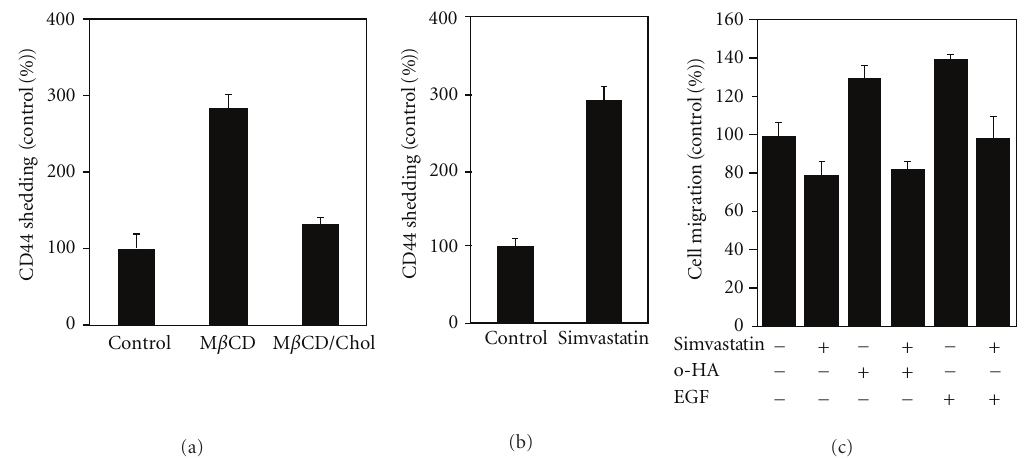
Figure 1: Cholesterol lowering stimulates CD44 shedding and suppresses cancer cell migration. (a) Modulation of cellular cholesterol a ff ects CD44 shedding from human glioma cells. Cells were cholesterol-depleted (M β CD), cholesterol-replenished (M β CD/Chol), or left untreated (control), and CD44 shedding was assessed by measurement of soluble CD44 in the culture medium. (b) E ff ect of simvastatin on CD44 shedding. Cells were incubated in the presence or absence of simvastatin, and CD44 shedding was assessed by measurement of soluble CD44 in the culture medium. (c) E ff ect of simvastatin on CD44-dependent cell migration. Cells were incubated in the presence or absence of simvastatin, and treated with hyaluronan oligosaccharides (o-HA) or EGF.